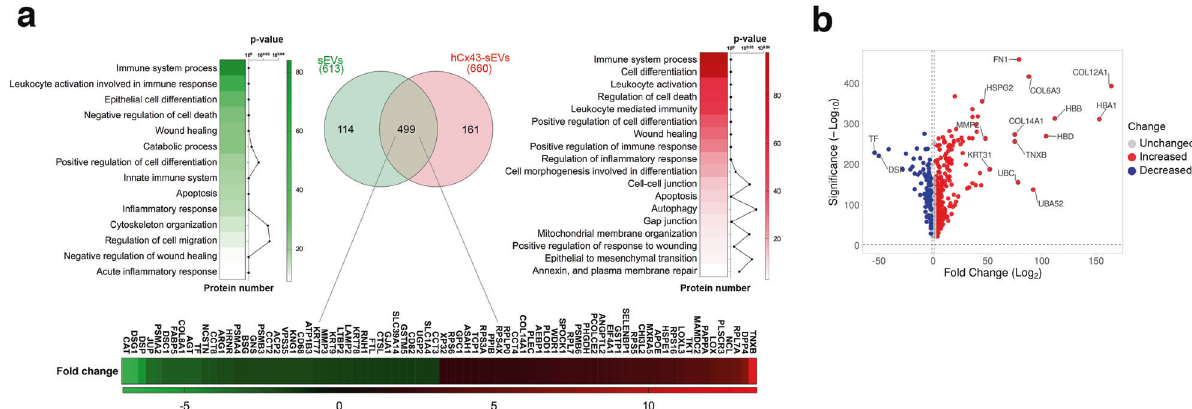
Fig. 6 Proteomic analysis of proteins isolated from sEVs derived from untreated human osteoarthritic chondrocytes (sEVs) or Cx43- enriched after oligomycin treatment (hCx43-sEVs). a Venn diagram indicating the number of proteins identi fi ed in the proteomic analysis, and the heatmap of enriched pathways present in each group ( n = 4). 114 proteins were exclusively found in sEVs isolated from OA-derived chondrocytes (left) and 161 were only identi fi ed in hCx43-sEVs (right). 499 common proteins (middle circle) were identi fi ed in both samples. Heatmaps represent signi fi cant function and pathways enriched in exclusive and common detected proteins, and analysed using STRING enrichment analysis (Gene Ontology and KEGG) based on quantitatively upregulated and downregulated proteins. b Volcano plot (VolcaNoseR) illustrating the correlation of fold change derived from the semiquantitative parameter spectral count and its signi fi cance, of the common proteins presents in both groups (sEVs from OA-derived chondrocytes-derived and sEVs derived from hCx43). also overrepresented in sEVs-T/C-Cx43 by 1.3 folds (Tables S2, S3, metalloproteinase 1 (MMP-1) was exclusively detected in sEVs S6). Critical proteins involved in wound-healing pathway including derived from Cx43-overexpressing chondrocytes (hCx43-sEVs) Cx43, mTOR, MYH10, LOX or MAPK3 and proteins classi fi ed within (Table S2) and is both associated with senescence as one of the the immune response pathway were signi fi cantly overrepresented main SASP components [40] and OA progression [41]. MMP-2 was Cell Death and Disease (2022)